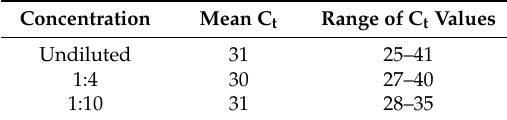
Table 6. Summary of demonstration exercise